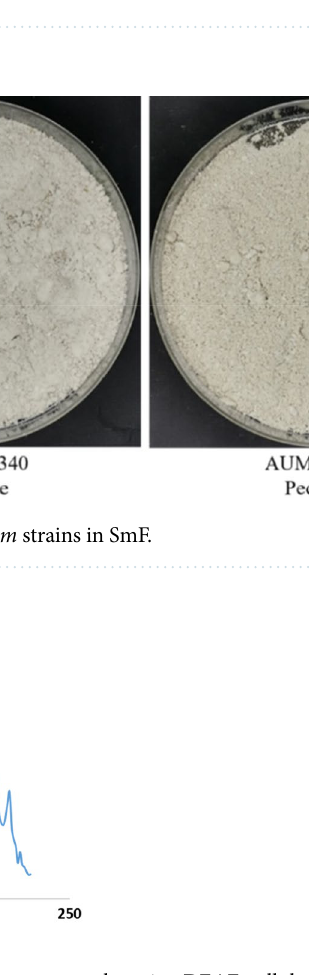
Figure 14. Purification of pectinase by ion exchange chromatography using